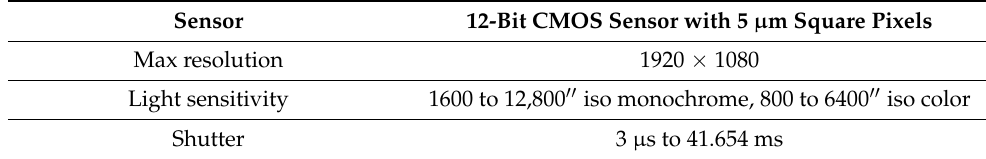
Table 3. Speci fi cations of the high-speed FASTEC IL5 camera used.